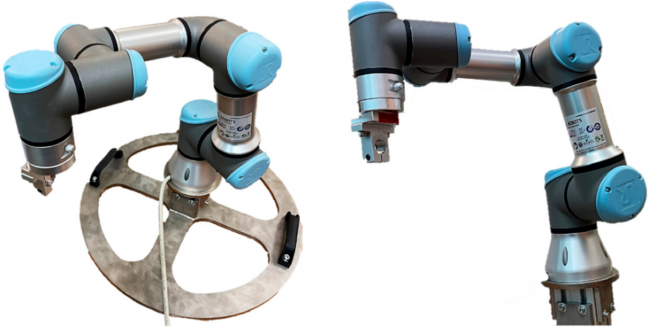
Figure 2. Photo of the UR-3 e-series cobot by Universal